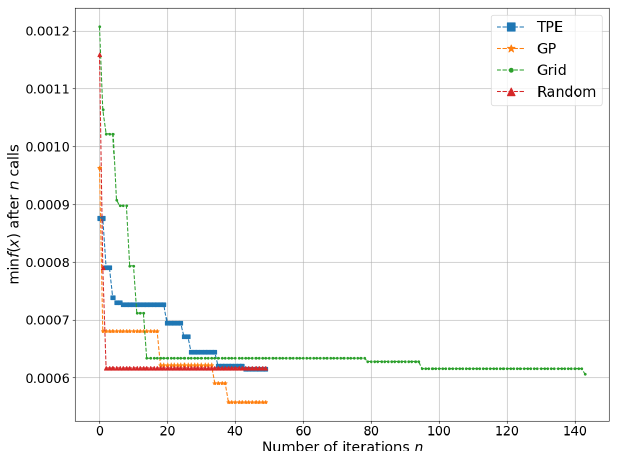
Figure 9. Comparison of four optimization algorithms for optimiz- ing hyperparameters of an LSTM-based model for rainfall–runoff modeling. GP represents Bayesian with Gaussian processes, while TPE stands for tree-structured Parzen estimator. Grid and random stand for grid-search- and random-search-based optimization, re- spectively. The x axis shows the number of function evaluations, while min f (x) on the y axis represents the objective function, which takes x hyperparameters and returns the minimum of vali- dation